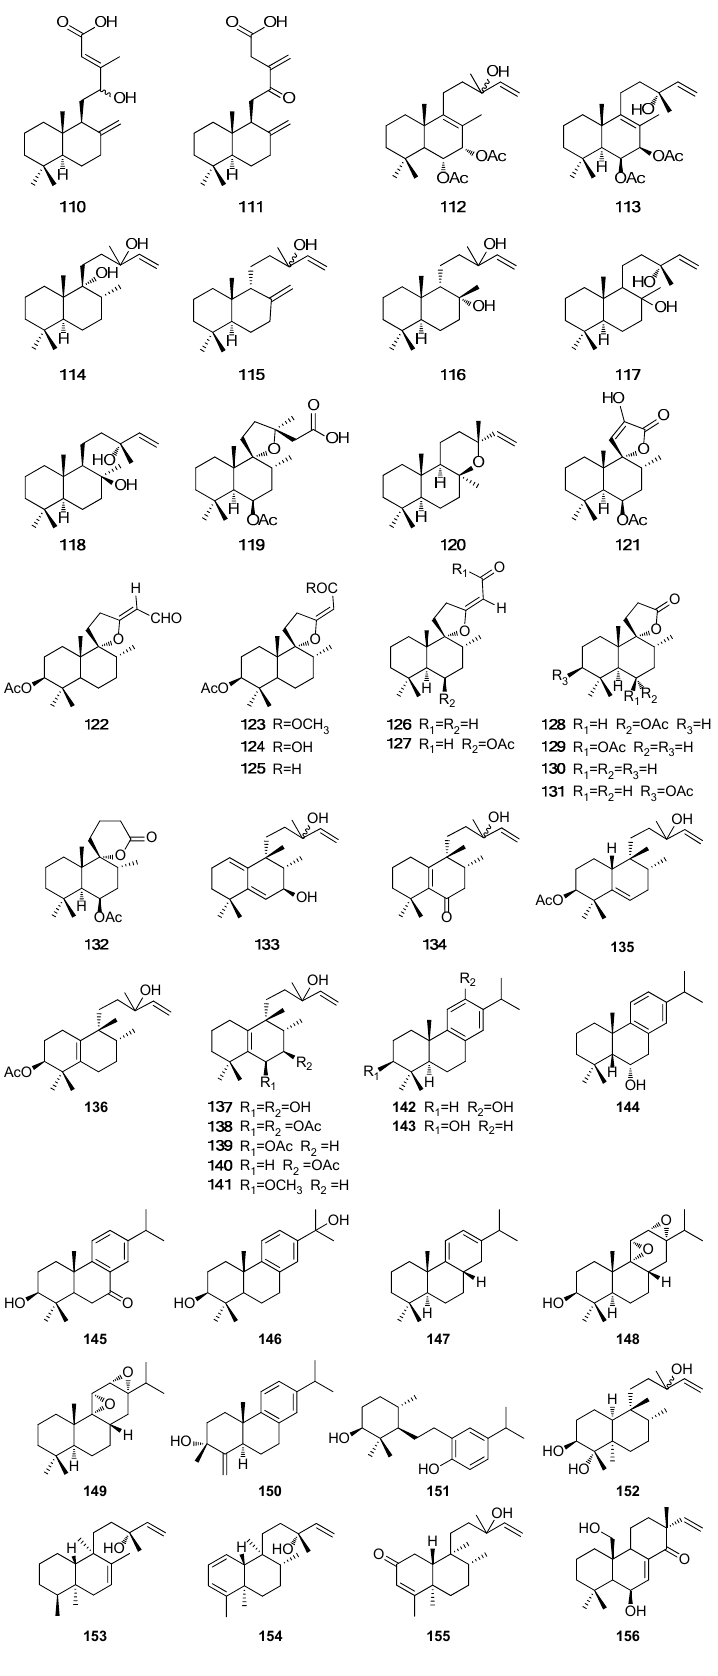
Figure 3. Structures of diterpenoids 43 – 156 isolated from Vitex L .